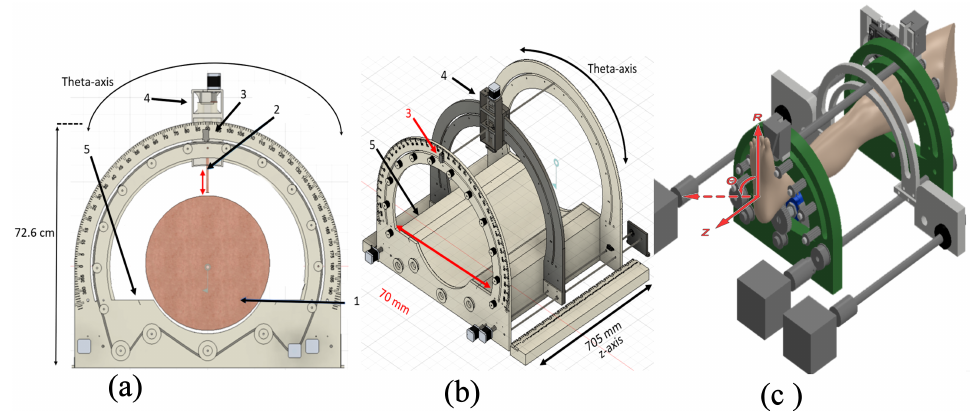
Figure 2. Stereotactic positioning system. ( a ) Front view to show a human leg (1), micro-coaxial antenna (2), visual theta indicator (3), antenna holder (4), and leg support (5); ( b ) isometric view show- ing the final dimensions of the Z-axis; ( c ) representation of the entire system with the corresponding axes and the leg